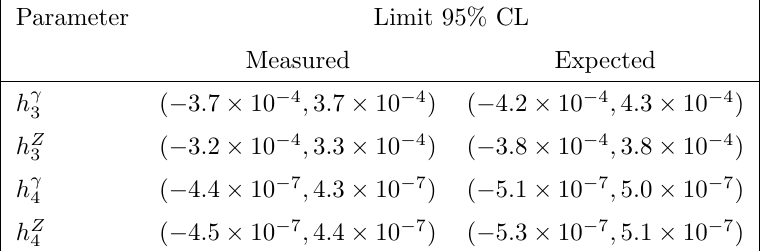
, h Z , h (cid:13) and h Z , assuming 3 4 3 4 or h V . 3 4